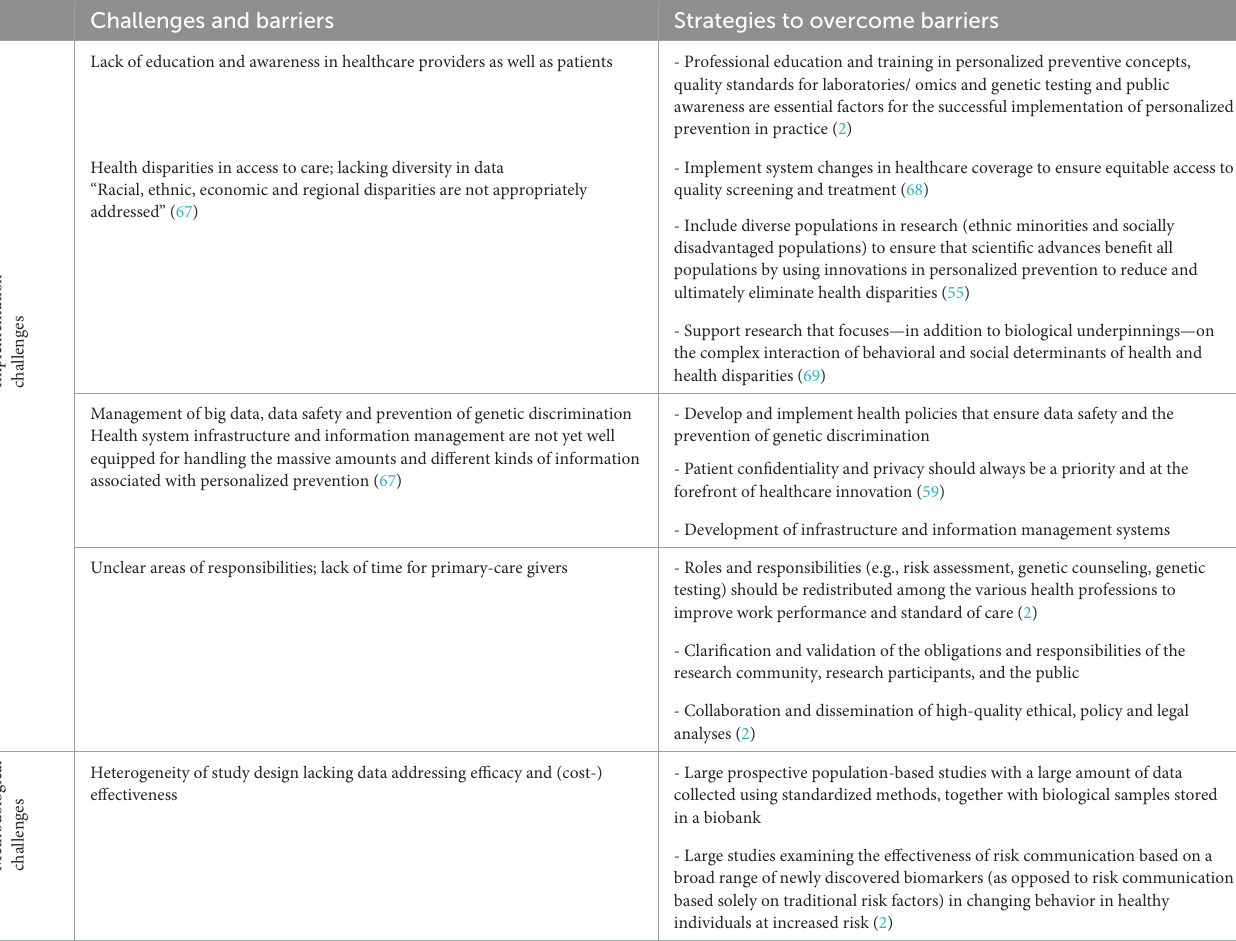
TABLE 3 Challenges and barriers for a successful implementation of personalized prevention in healthcare practice and strategies to overcome those. Challenges and barriers Strategies to overcome